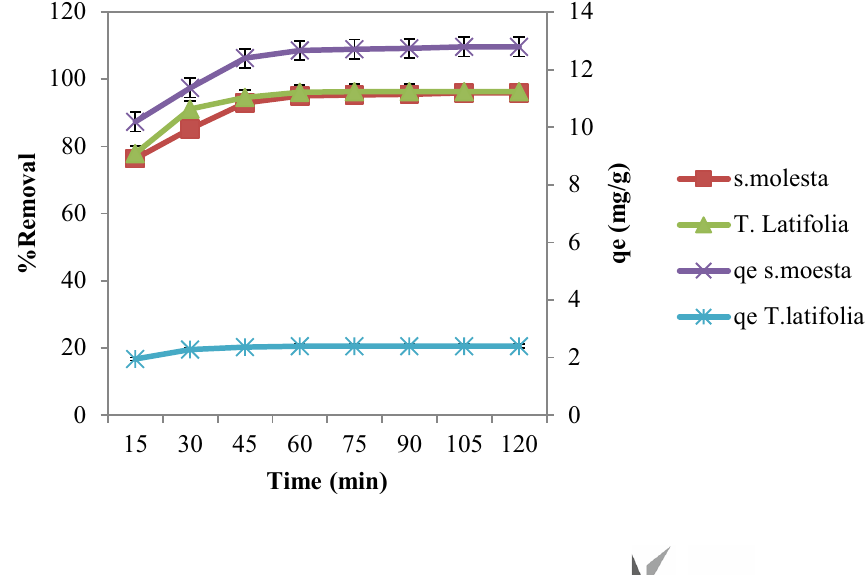
Fig. 7 Effect of time on Cr 6+ adsorption by S. molesta and T.